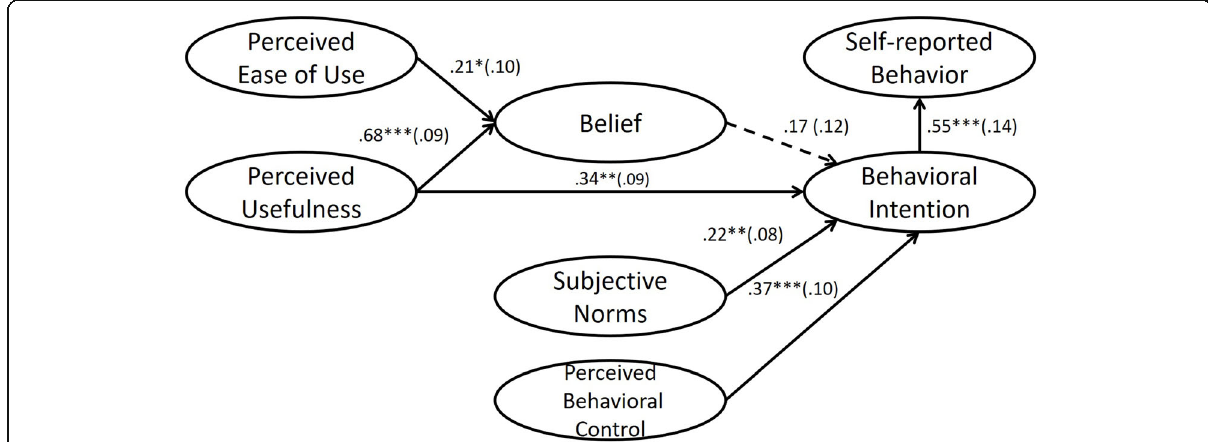
Fig. 12 The final TTBIM was based on the questionnaire data from 95 respondents. Solid lines indicate significant associations; dotted lines indicate nonsignificant associations. Arrows indicate the direction of the relationships. Figures in parentheses represent the standard error (SE). *** p < .001; ** p < .01; * p <